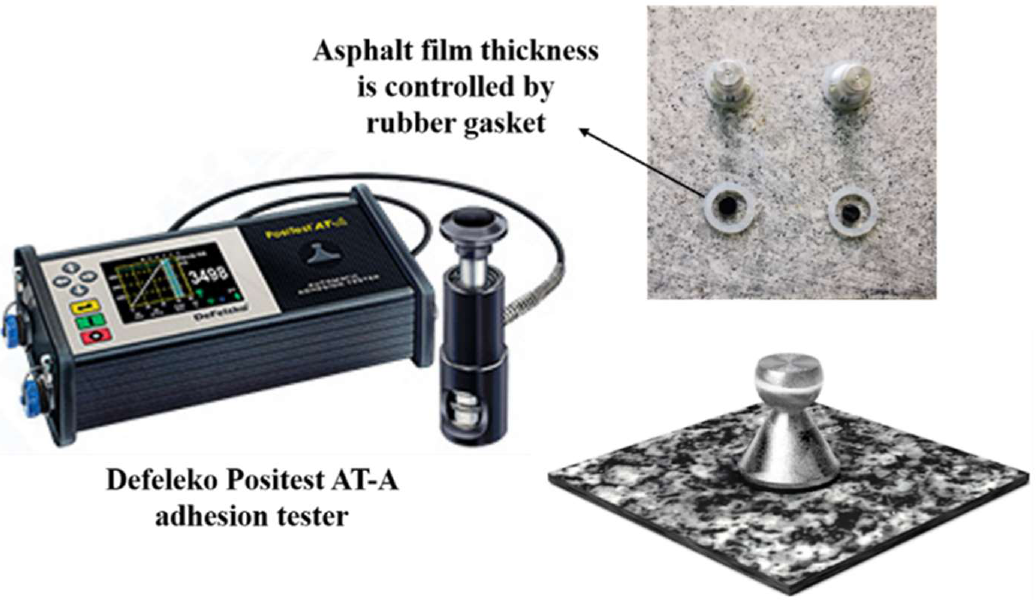
Figure 1. The process of the BBS test.